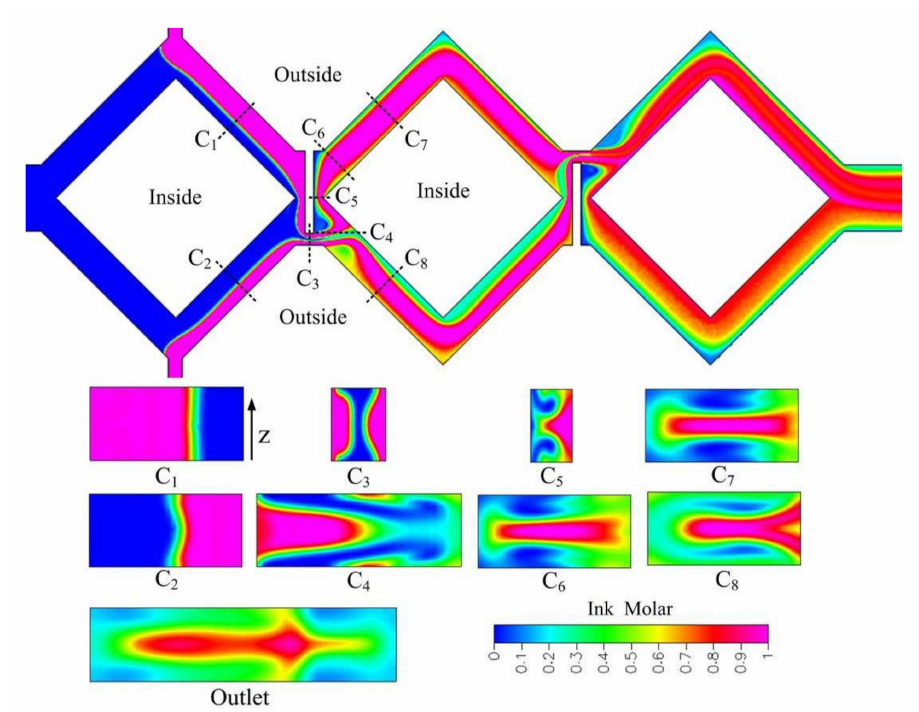
Figure 20. Cross-sectional concentration distributions of the three-rhombus micromixer with a gap ratio of 1/8 at Re 23.8 (x-y cross section is at half-depth